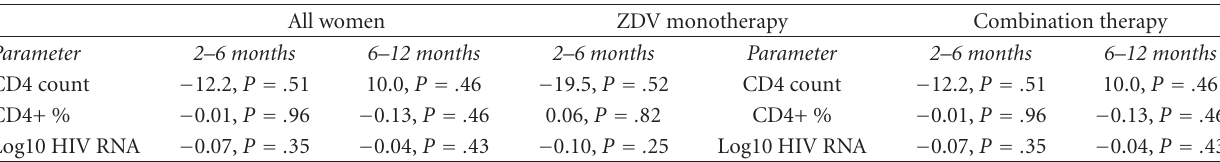
Table 2: Di ff erence in slope and P -values between women stopping or continuing therapy after delivery, according to antiretroviral therapy use during pregnancy.